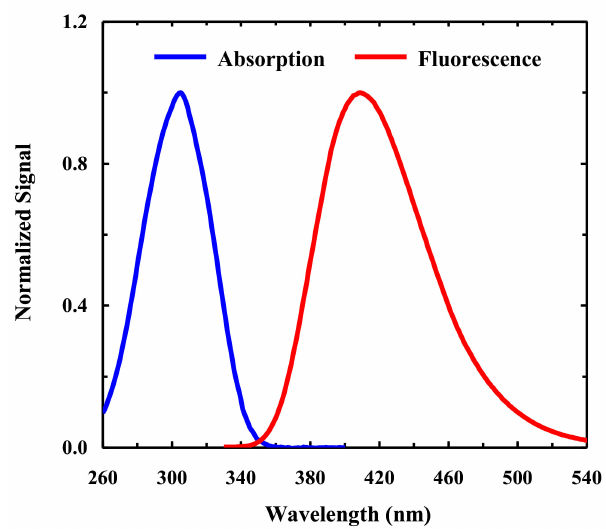
Figure 2. Normalized absorption and fluorescence spectra of 4-cyanoindole-2 (cid:48) -deoxyribonucleoside (4CNI-NS) ( λ ex = 320 nm) in water, as indicated.